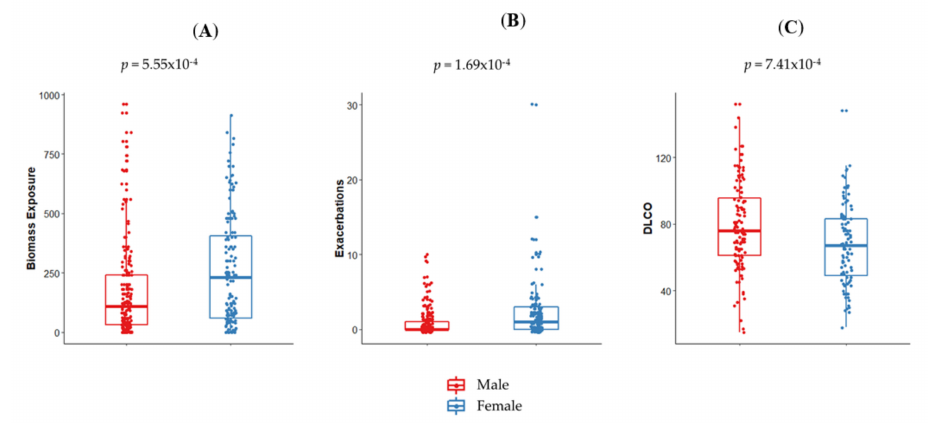
Figure 1. Sex di ff erences in clinical and exposure parameters in chronic obstructive pulmonary disease (COPD) patients. Female COPD patients showed an increased exposure to in-home biomass smoke ( A ) and exacerbations in the previous year ( B ), whereas males exhibited a better carbon monoxide di ff using capacity of the lung (DL CO ) ( C